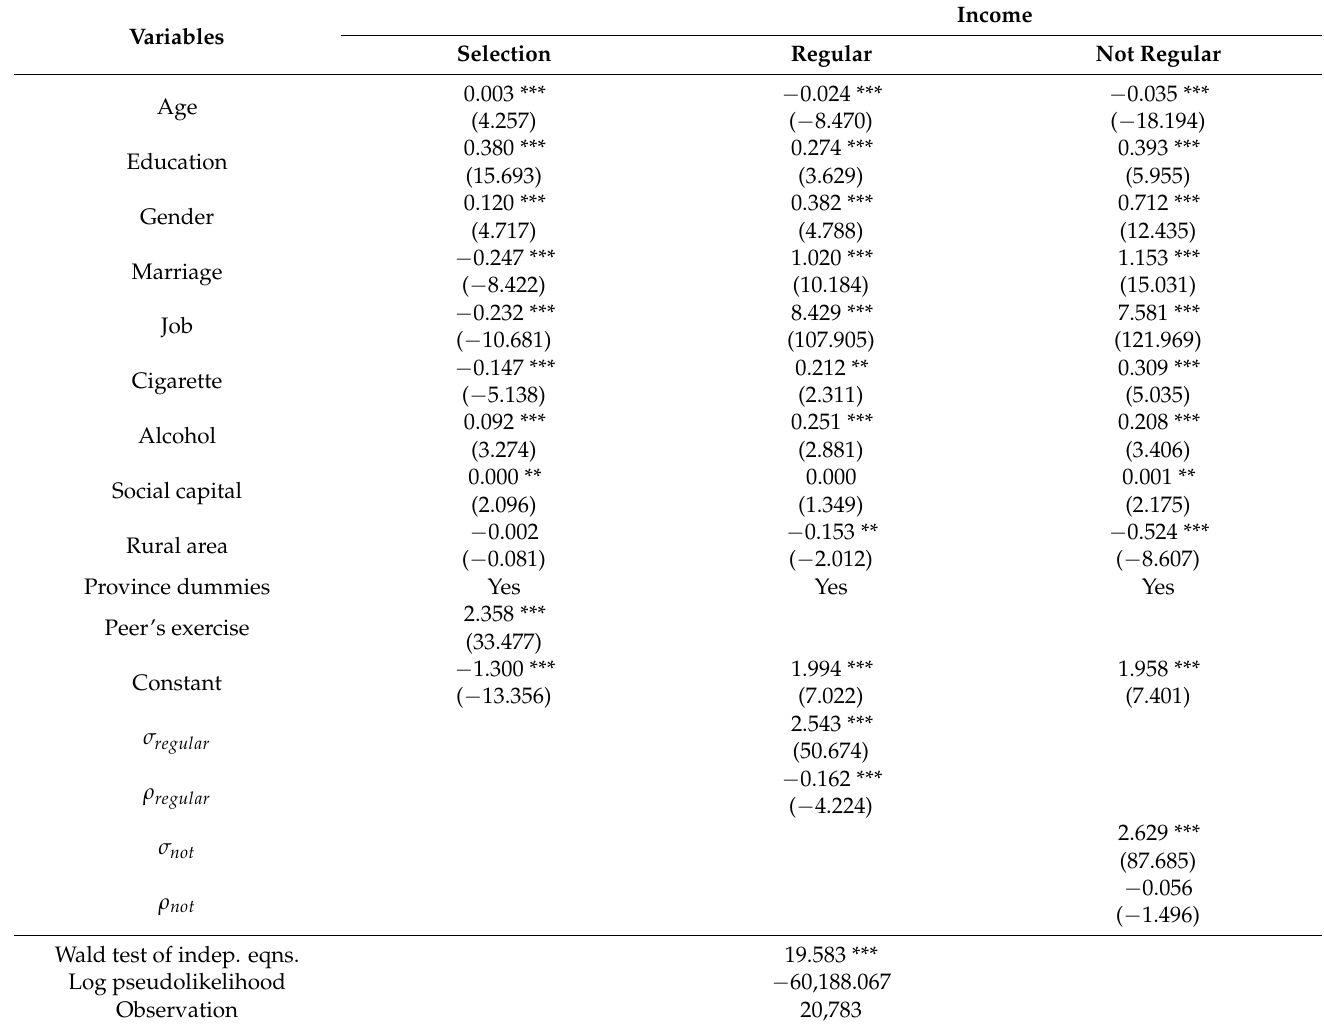
Table 3. Determinants of regular exercise and determinants of personal